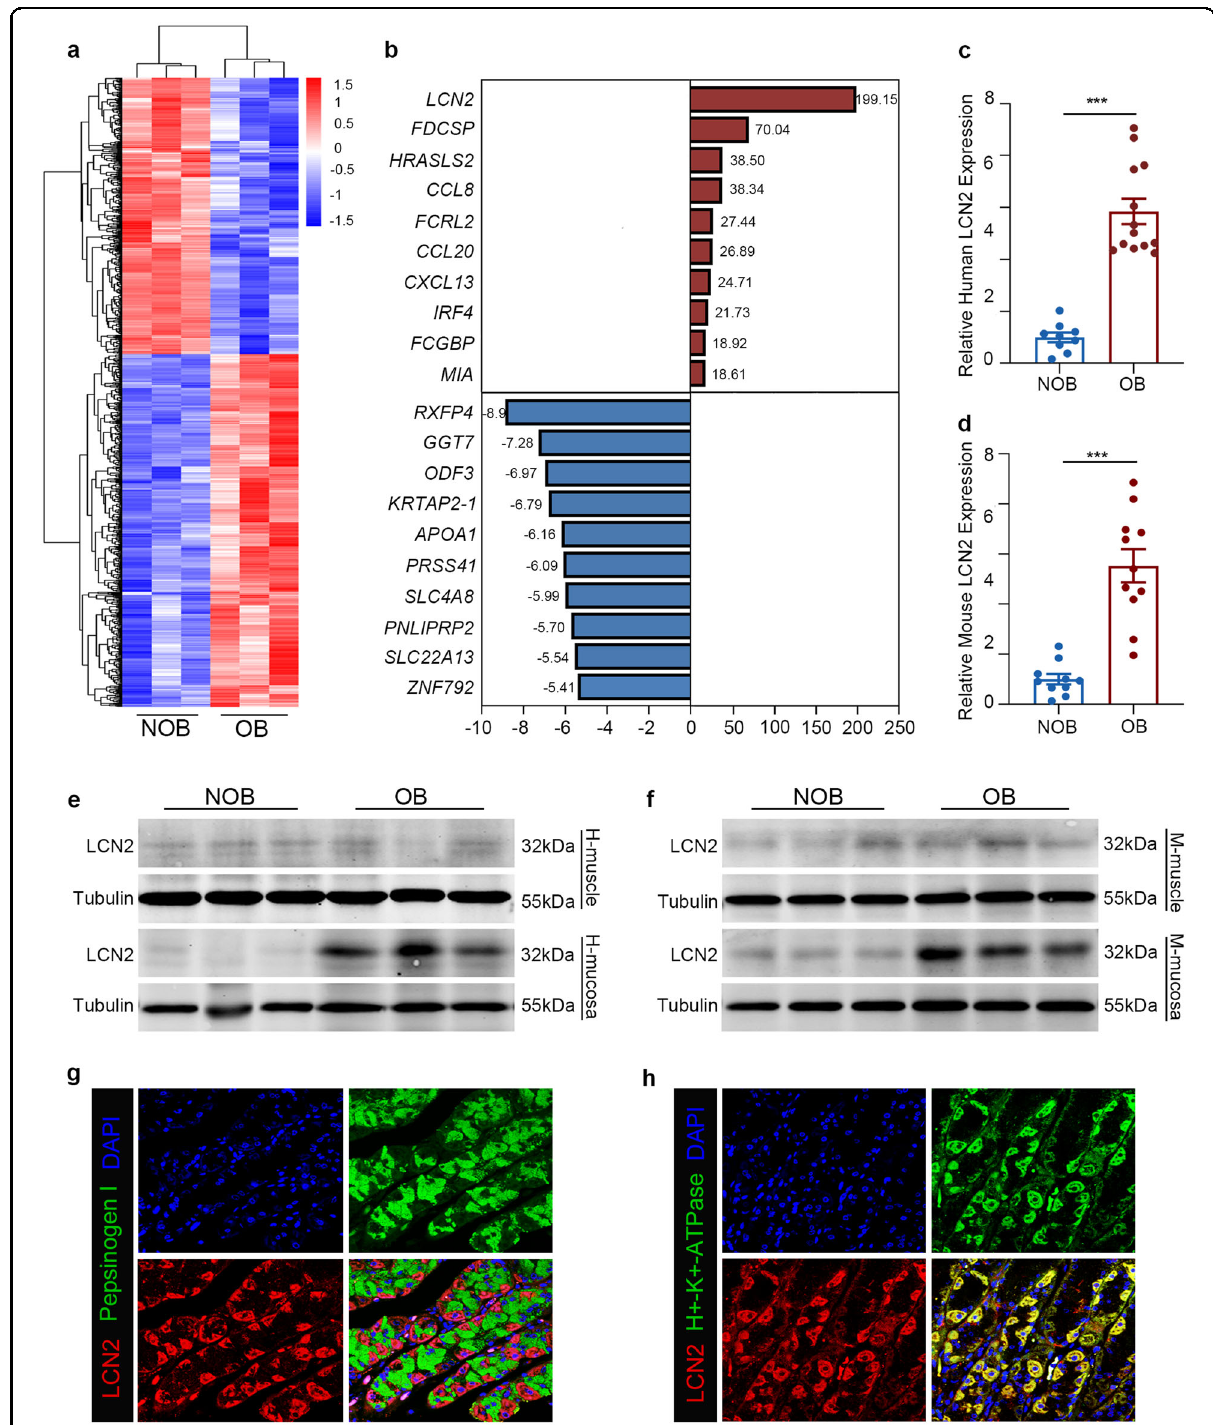
Fig. 1 LCN2 levels are elevated in obese group, and LCN2 is localized to parietal cells. a Heatmap of differentially expressed genes between obese individuals and normal controls. Red and blue characterize up-regulated and down-regulated genes, respectively. n = 3(NOB patients), n = 3 (OB patients). b Top 10 up- and down-regulated genes in microarray analysis. c, d , mRNA expression of LCN2 in gastric mucosa of humans ( c ) n = 9 (NOB patients), n = 13(OB patients) or mice ( d ) n = 10(NOB mice), n = 11(OB mice). Western blot analysis of LCN2 levels in gastric mucosa and muscle of humans ( e ) or mice ( f ). Tubulin was used as a loading control. Representative immuno fl uorescence staining shows ( g ) lack of co- localization of LCN2 (red) with marker Pepsinogen I (green) in chief cells, and ( h ) co-localization of LCN2 (red) with marker H + -K + -ATPase (green) in parietal cells. Data are mean ± s.e.m.; *** P < 0.005 (Student ’ s t